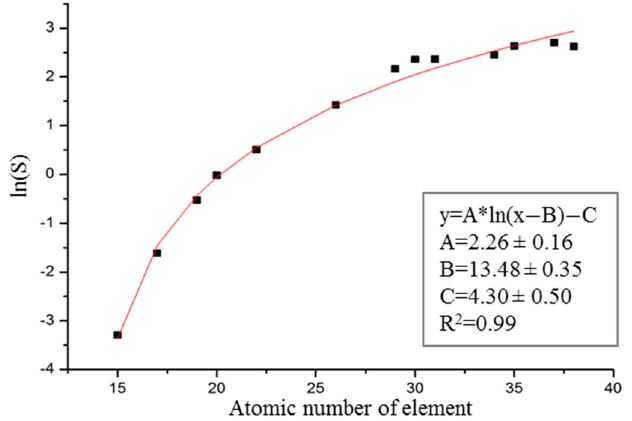
Figure 1. Sensitivity curve determined from the measurements of the MICROMATTER XRF calibra- tion standards.